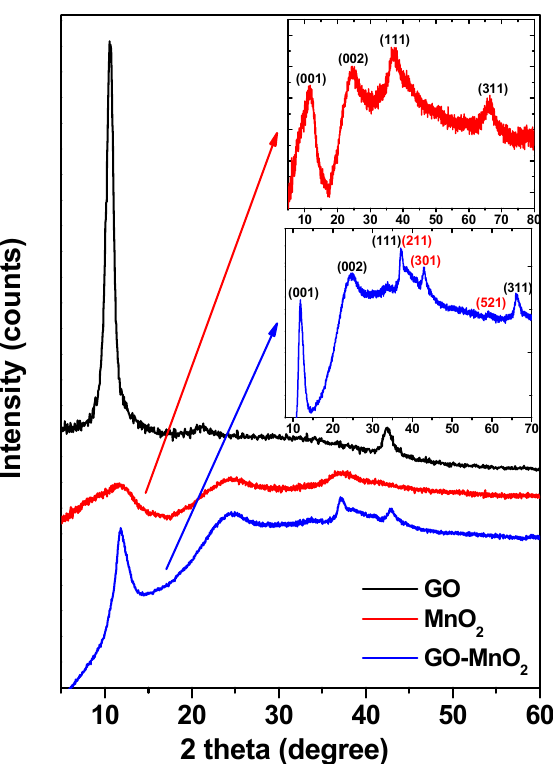
Figure 1. XRD patterns of graphite oxide (GO), manganese oxide (MnO 2 ), and GO ‐ MnO 2 XRD patterns of graphite oxide (GO), manganese oxide (MnO 2 ), and GO-MnO 2 nanocomposite. 2 θ (degrees). nanocomposite. 2 θ